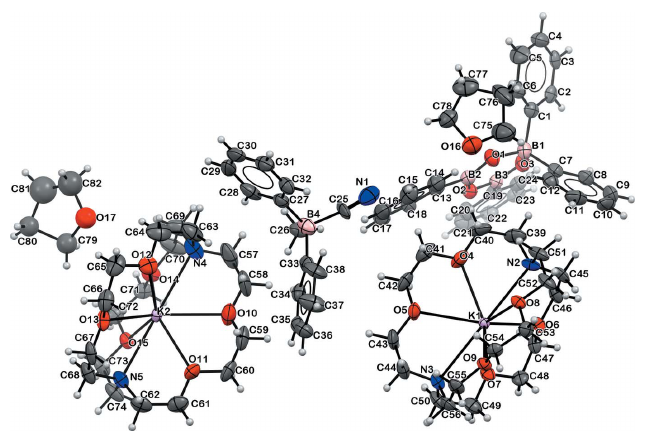
Figure 4 Displacement ellipsoid plot of 4 , [K(crypt)] 2 [B 3 ( (cid:4) -O) 3 (C 6 H 5 ) 4 ]- [NCBPh 2 Me], drawn at the 50% probability level.